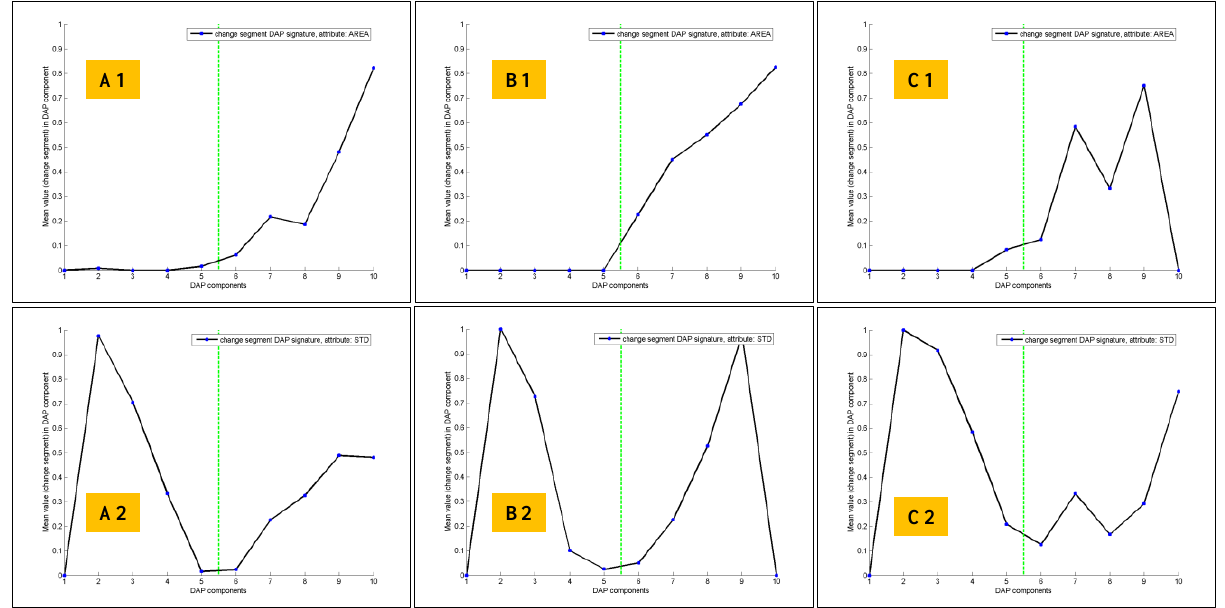
Figure 1: DAP signatures of three different change segments. A1 (A2): Change segment on highway parking place, attribute area ( std ). B1 (B2): Moving target change segment, attribute area ( std ). C1 (C2): Other change segment, attribute area ( std ), see text for